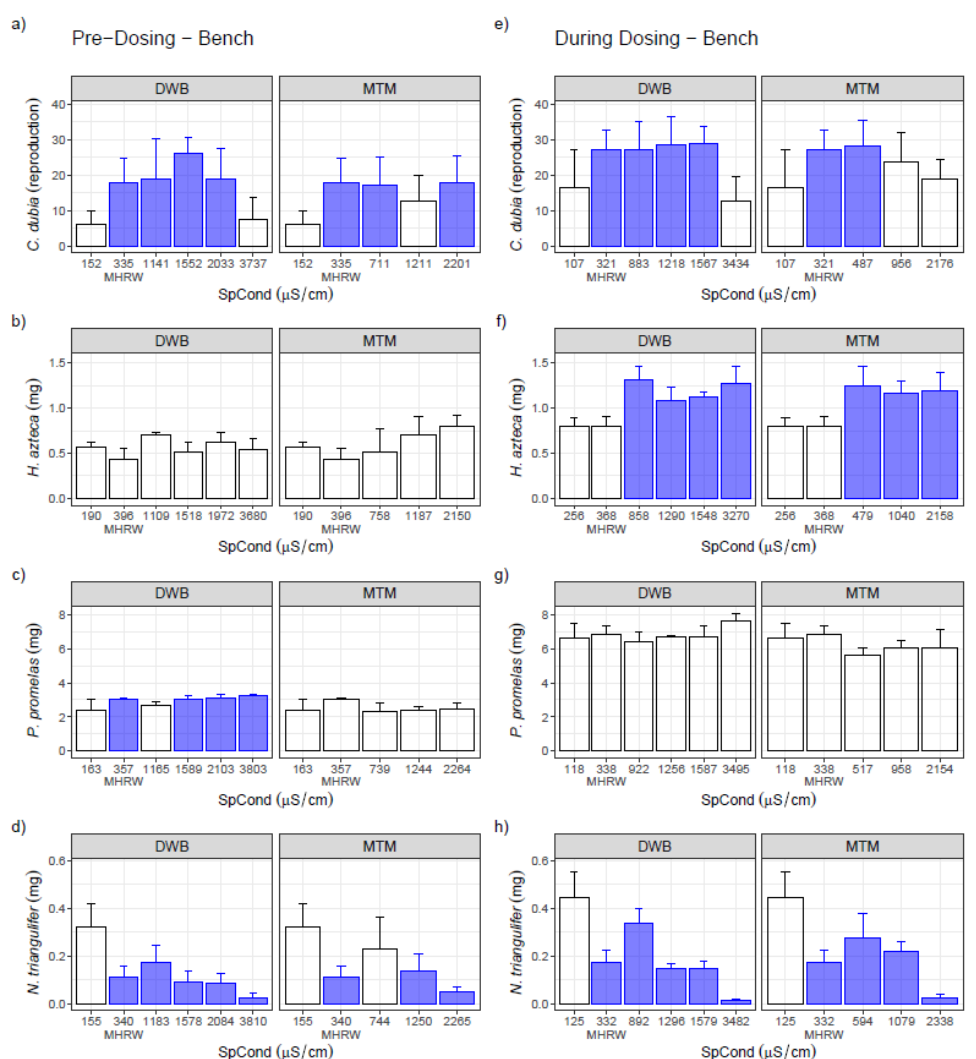
Figure 2. Single-Species toxicity tests using cultured individuals exposed to both DWB and MTM recipes and a moderately hard water (MHRW) control. Each test was run twice: pre (left panel) and during dosing (right panel): ( a , b ) are for C. dubia ; ( c , d ) are H. azteca ; ( e , f ) are P. promelas ; and ( g , h ) are for N. triangulifer . Data are means per dose ± 1 sd, with n = 3 per dose. Colored bars represent significant difference from control ( p < 0.05) per Dunnett’s test.